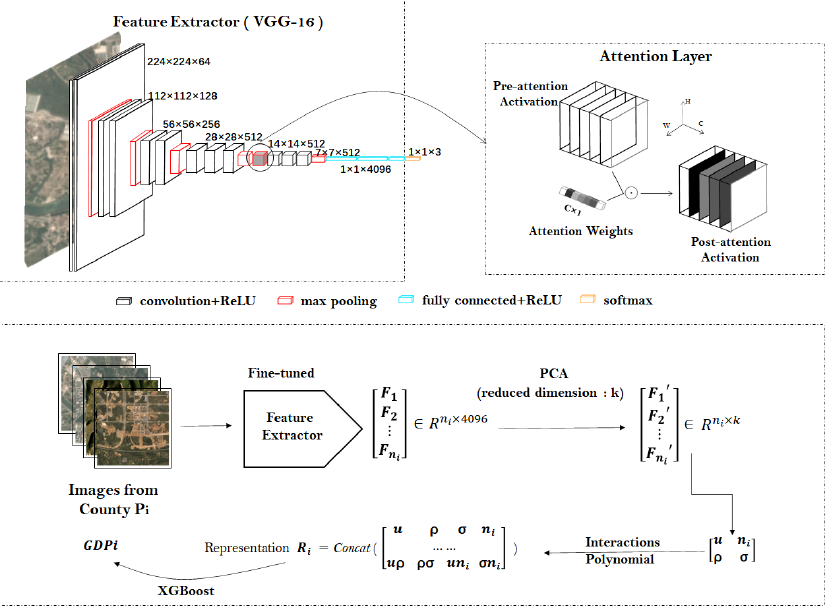
Figure 4. The structure of our method. Our method operates in three steps. (1) An attention- augmented VGG-16 network pre-trained on ImageNet [38] is tuned to predict nighttime light intensity levels from daytime satellite images. The middle blocks of the network are taken out as the feature extractor after transfer learning (the pre-trained VGG-16 network) and supervised training (nightlight intensity degrees as a proxy of socioeconomic indicators). (2) Reduce the dimensions of output features via PCA. (3) Calculate the embedded spatial statistical characteristics and apply regression models to predict the logarithm of county-level